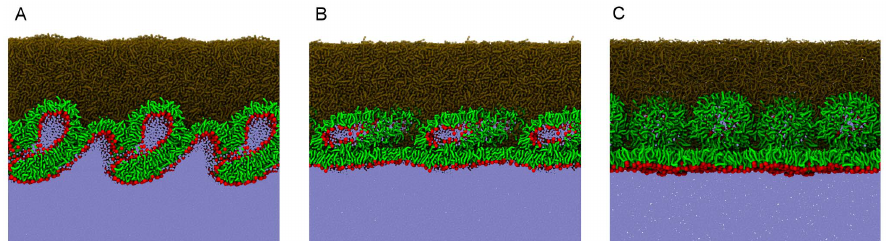
Figure 8. Typical simulation snapshots taken during the non-equilibrium lateral compression. The snapshots are taken before (A) and after (B) extrusion of polar lipids and water to the non-polar subphase; and during decompression (C). For color coding, see Fig.2A. For presentation purposes, in each snapshot three periodic images in the lateral direction are depicted (corresponding to 47–50 nm).